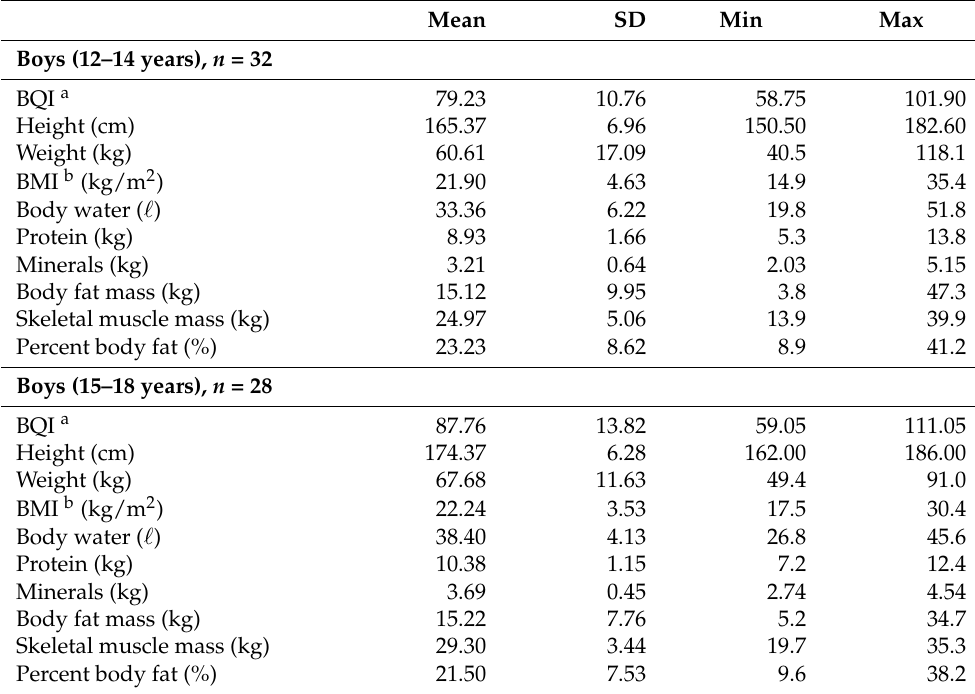
Table A1. Body composition classified by gender and